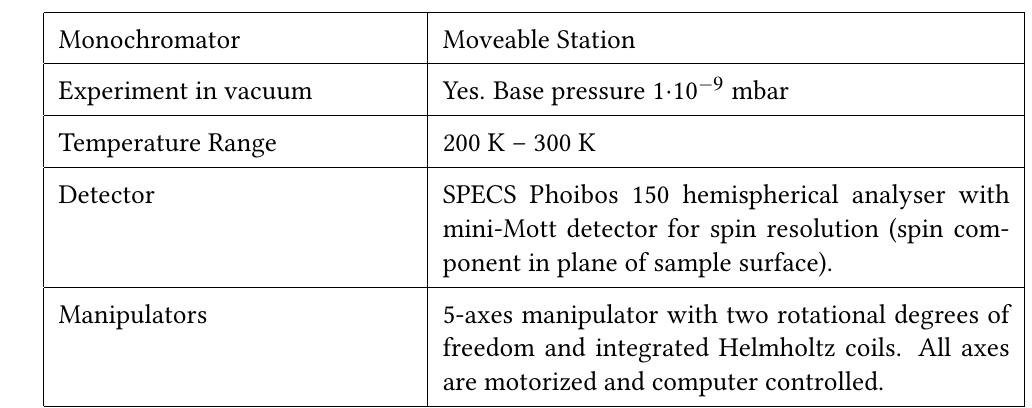
Table 1: Technical parameters of the PHOENEXS station.